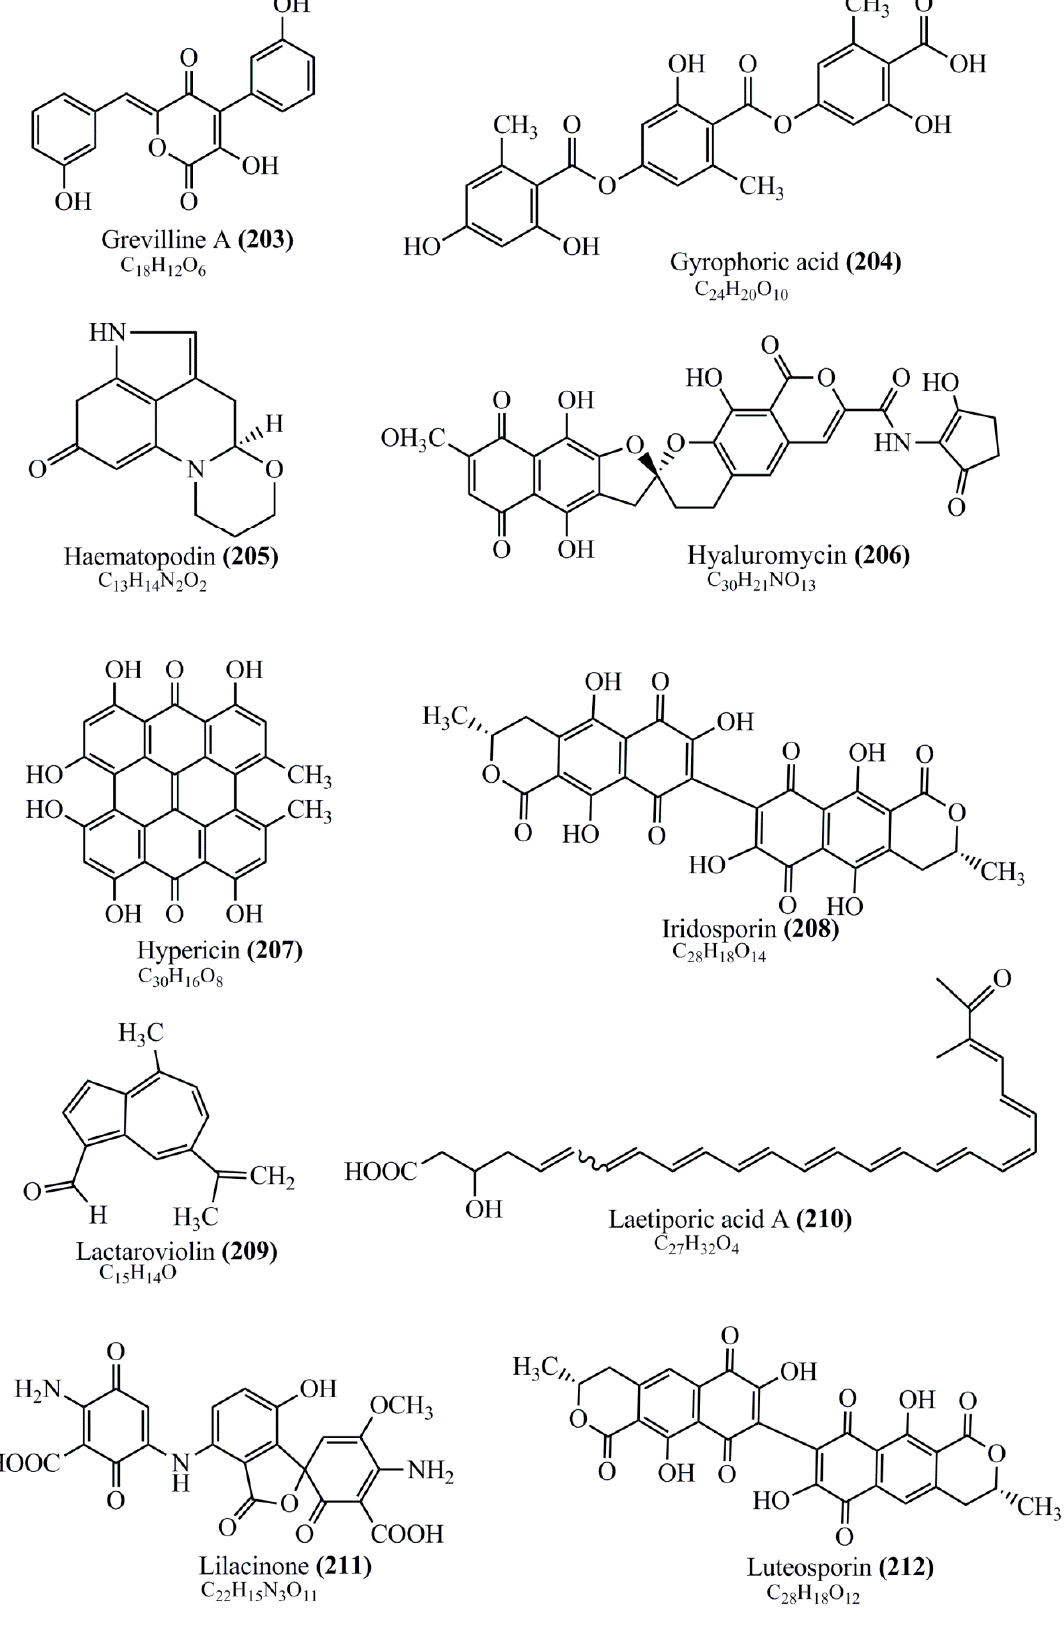
Figure 1. Continued. Figure 1.